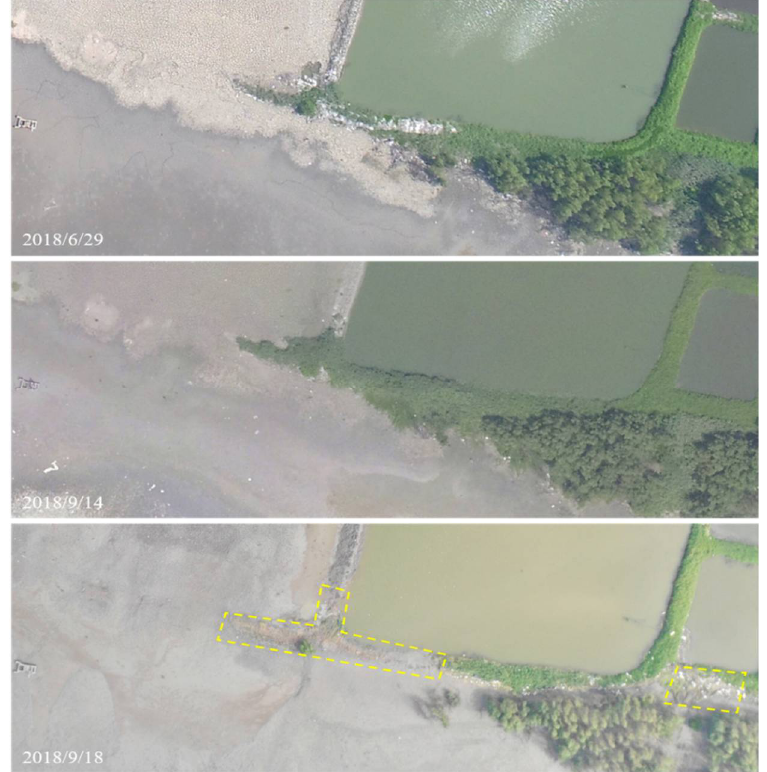
Figure 7. Aerial photos compare the fishpond embankment at the western edge of the mangrove forest (i.e., the yellow-line bounded area in Figure 1c) on June 29 ( top photo ), before (September 14, forest (i.e., the yellow-line bounded area in Figure 1c) on 29 June ( top photo ), before (14 September, middle photo ) and after (September 18, bottom photo ) the typhoon influence. Obvious embank- middle photo ) and after (18 September, bottom photo ) the typhoon influence. Obvious embankment ment breakage was shown by the dashed yellow-line bounded areas. breakage was shown by the dashed yellow-line bounded